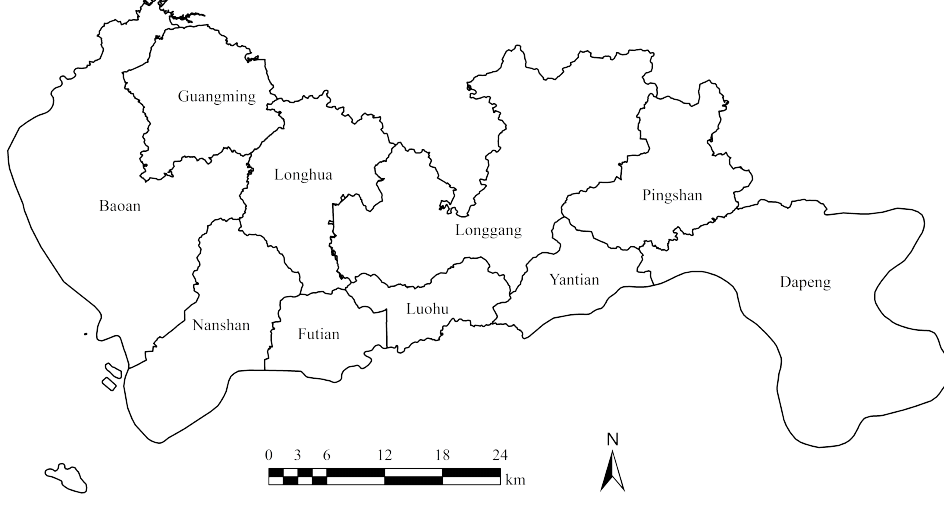
Figure 4. The administrative region in Shenzhen